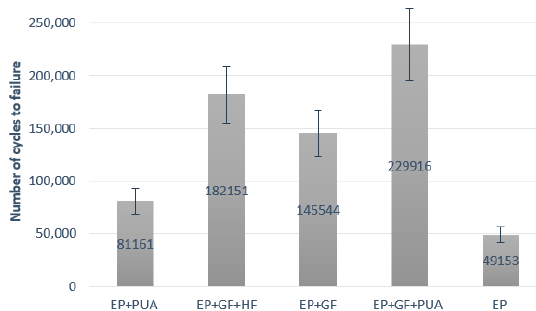
Figure 9. Number of cycles to failure (mean of five) for samples with different coatings. The macroscopic images of broken specimens are presented in Figure 10.